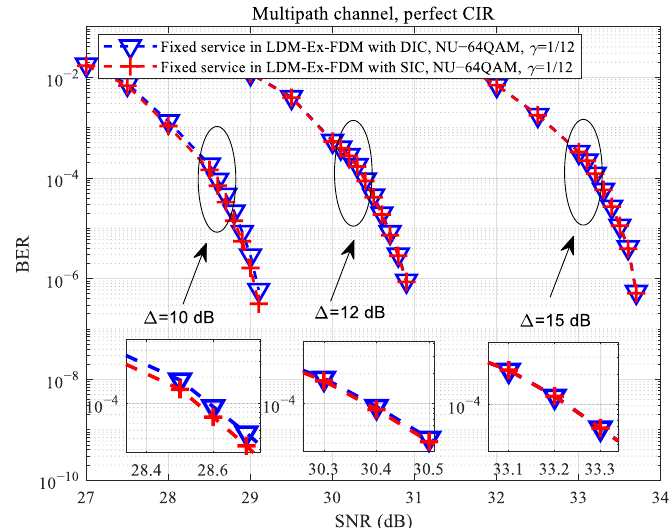
Figure 19. BER performance of fixed service in the LDM-Ex-FDM scheme with direct interference cancellation (DIC) and successive interference cancellation (SIC) with perfect channel impulse response (CIR) under the multipath channel, where the parameters of the ATSC 3.0 system were set to  = 10 dB, 12 dB, 15 dB, the CL constellation was set to QPSK, the EL constellation was set to NU−16QAM, and the puncturing rate was set to 1/12.